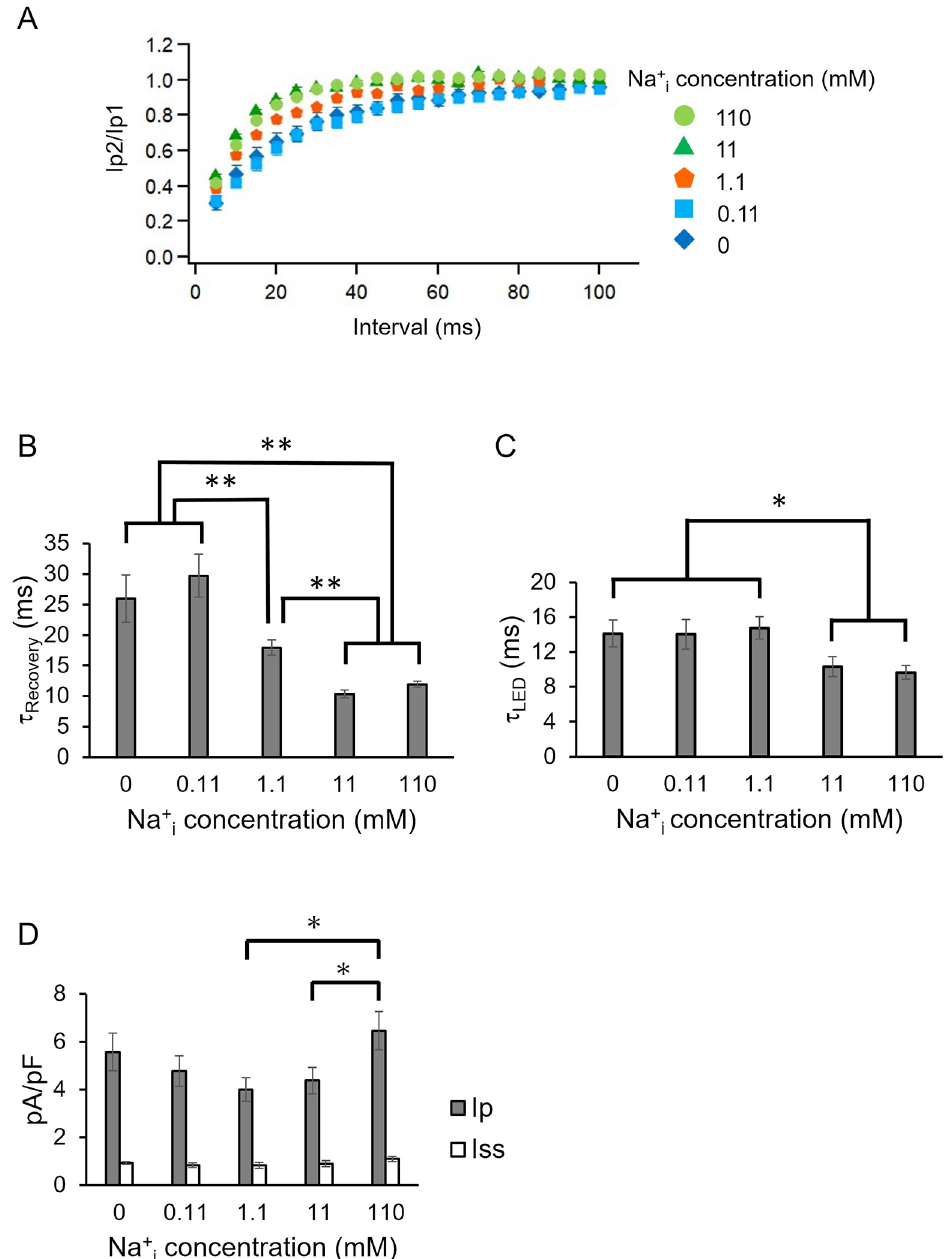
Fig 3. Effect of intracellular Na + concentration. A, The recovery kinetics of the second peak photocurrent in the presence of various NaCl concentrations at pH 7.4 in intracellular solution (n = 6–16). See Table for more details. The same recordings shown in Fig 2E were performed to assess the effect of Na + . B, Kinetic parameters ( τ Recovery ) obtained from A ( � p < 0.05, �� p < 0.01). C, Photocurrent kinetics after shutting the LED light ( τ offLED ) was determined under various NaCl concentrations inside the cell. D, Photocurrent amplitude in various NaCl concentrations inside the cell while the bath solution contained 140 mM NaCl (n = 10–14, � p < 0.05).